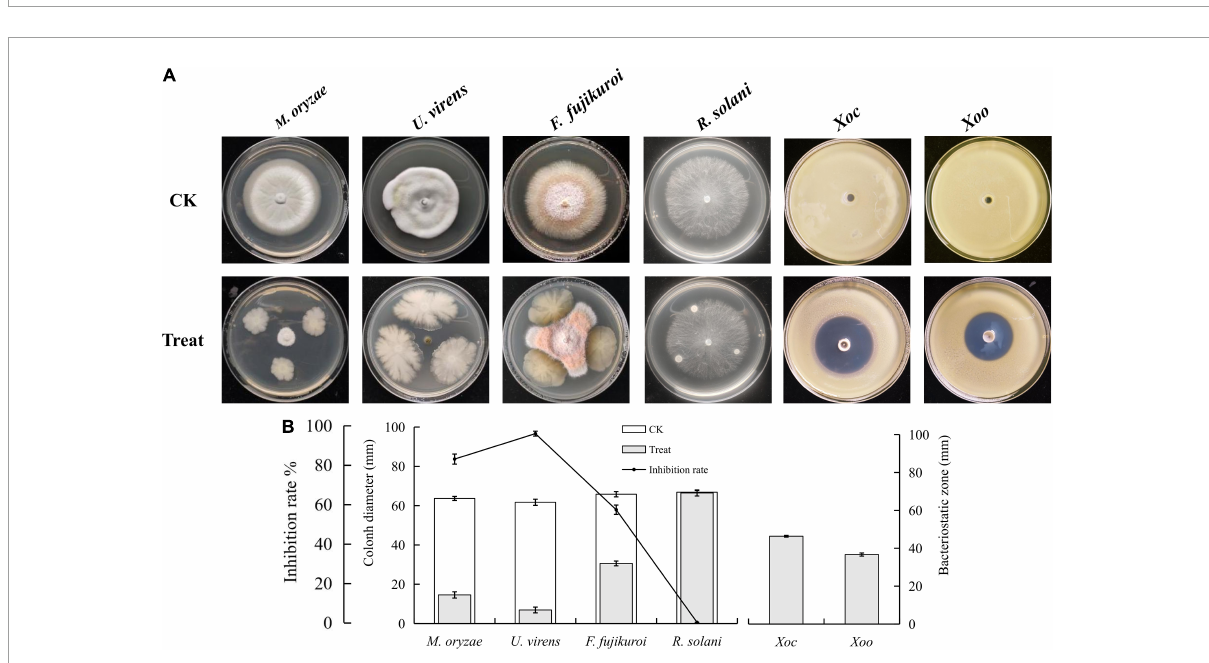
FIGURE2 (A) Antagonistic effects of BR-01 against a variety of rice pathogens and (B) data statistics. Inhibition rate of BR-01 on pathogenic fungi was measured when pathogenic fungi in control group grew to about 3/4 of culture dish. Values given are the means ± standard deviations of triplicate